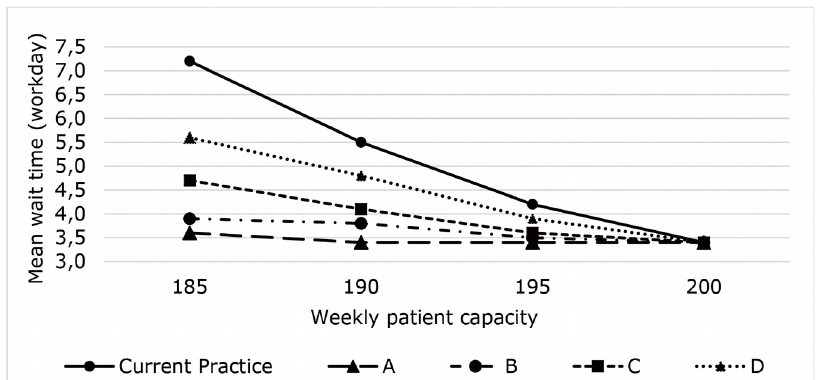
Figure 5. Effect of reserving new slots on patient